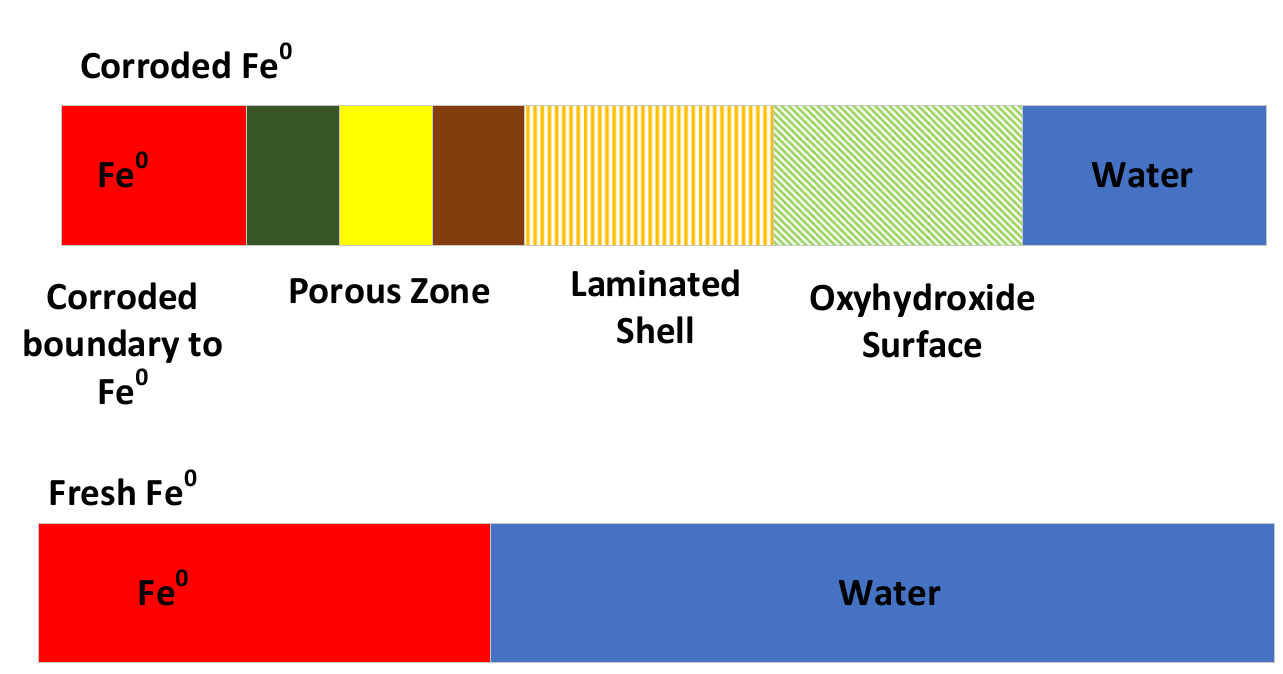
Figure 1. Corrosion structure of Fe 0 . The corrosion products are commonly called rust or scale. Red = Fe 0 ; Blue = water; Porous zone = Green + yellow + brown zones: Green = Fe 2+ products (Fe(OH) 2 , Fe(OH) + , FeCO 3 ; Yellow = Green rust products ([Fe 2+ ] n [Fe 3+ ] m (OH) y ; ([Fe 2+ ] n [Fe 3+ ] m (OH) y ) z+/ − ); Brown = Fe 3+ mononuclear hydroxyl polymers (Fe(a) products (Fe 3+ ; Fe(OH) 3 ; Fe(OH) 2+ ; Fe(OH) 2+ ; Fe(OH) 4 − (Fe 2 (OH) 24+ ; Fe 3 (OH) 45+ ; FeOOH; Fe 3 O 4 ); Laminate shell = Orange stripe = hydroxyl species: Fe 3 O 4 , FeOOH, Fe 2 O 3 , Fe(b) polynuclear polymers ( e.g., Fe(OH) 24+ ; Fe(O 2 H 6 ) 3+ ; Fe 3 (OH) 45+ ; Fe 5 (OH) 96+ ); Oxyhydroxide surface = Green diagonal stripe = Fe(c) larger colloidal polymers (Fe(OH) x ; FeOOH); For a specific water body pH, the Eh present on the particle and in the particle porosity varies. At a water = pH 8, for fresh Fe 0 , the Eh at the water:Fe 0 is − 0.5198 V. The Eh of the water body is > − 0.5198 V. In the corroded Fe 0 at pH 8, the Eh values are as follows: red:green boundary = − 0.5198 V; yellow:brown boundary = − 0.207 V; The Eh of the water body is > − 0.207 V. The pH of the red:green boundary will be 1 to 4 units lower than the average pH within the water body. This will reduce the Eh at this point by a further − 0.05 to − 0.24 V.